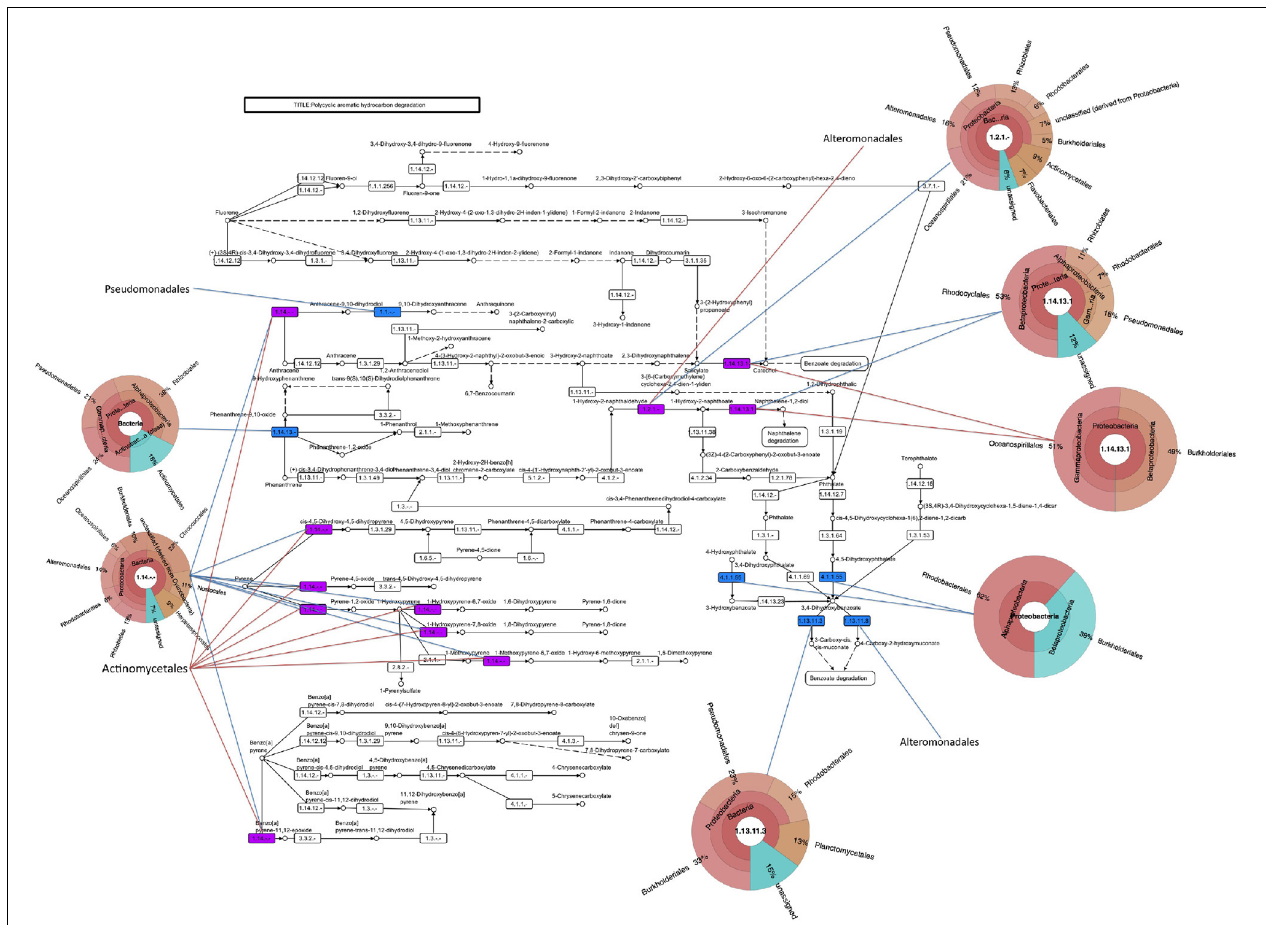
FIGURE 4 | Polycyclic aromatic hydrocarbon degradation pathway. Assembled contigs are mapped to pathway from the KEGG database and colored in blue for June 3, red for June 21, and purple